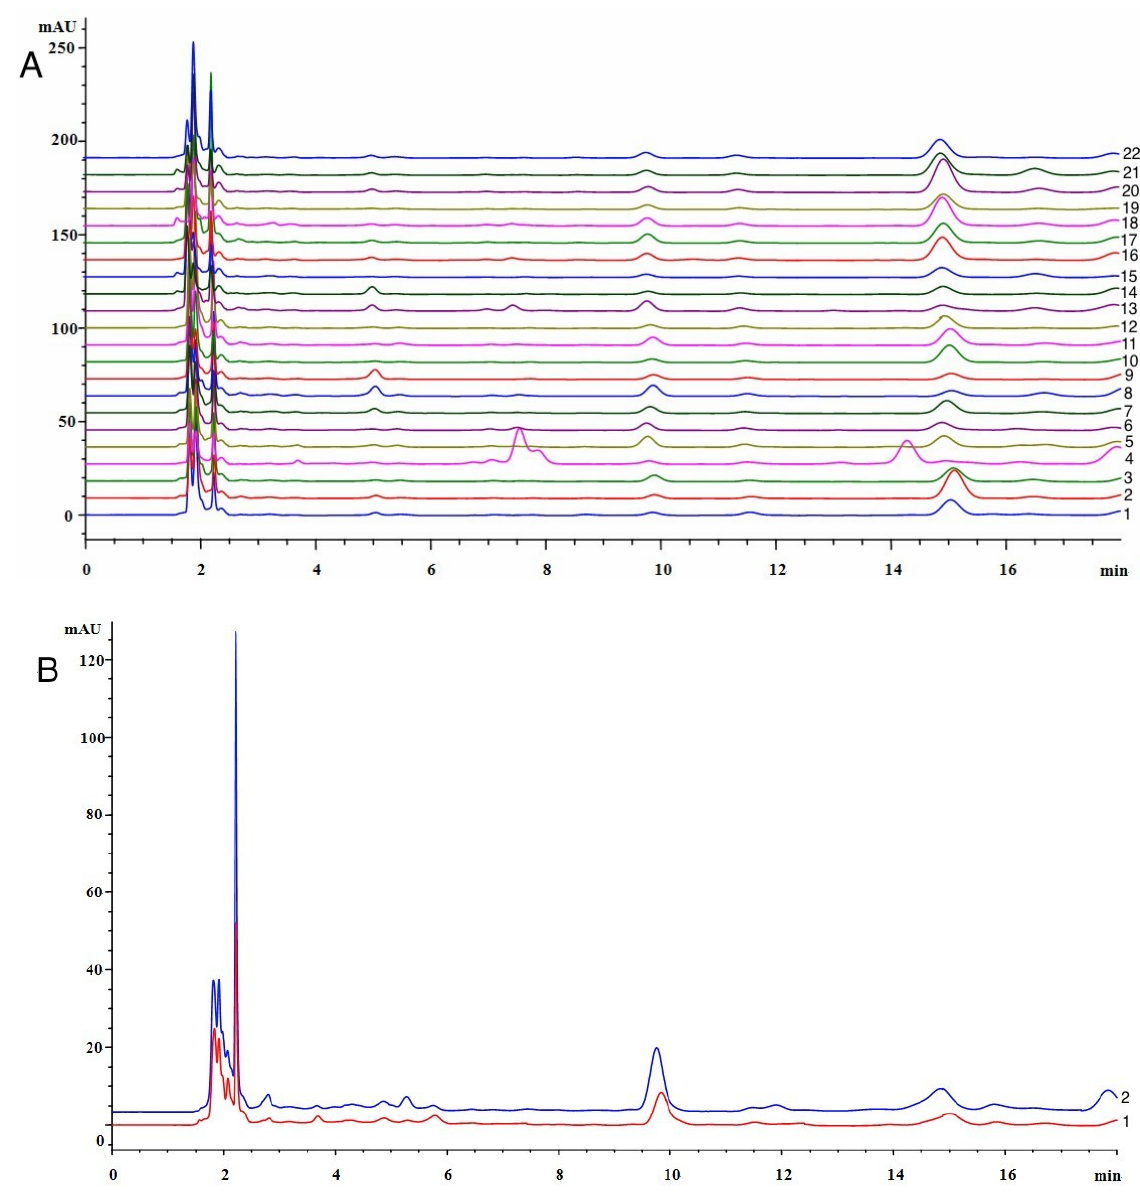
Figure 3. HPLC chromatograms of ( A ) 22 poplar type propolis; ( B ) two Baccharis dracunculifolia type proplis; ( C ) three Eucalyptus type